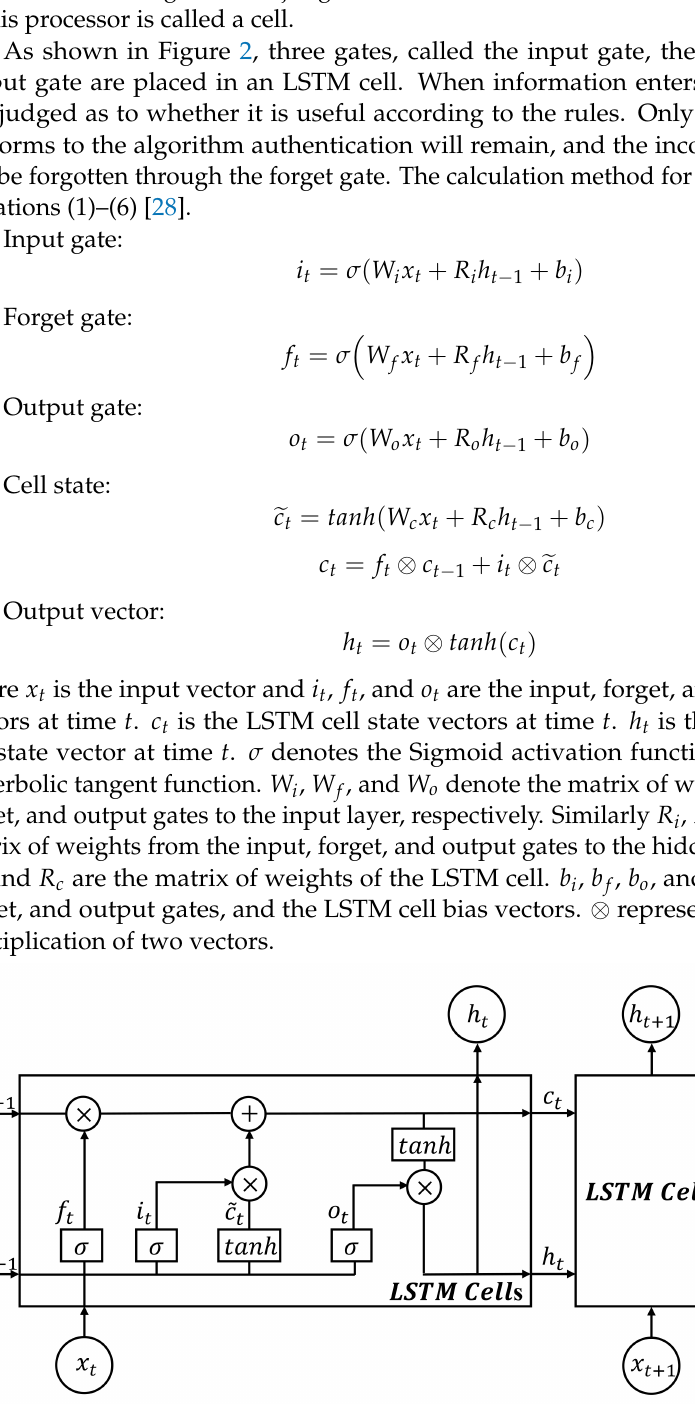
Figure 2. Neuron in the hidden layer of